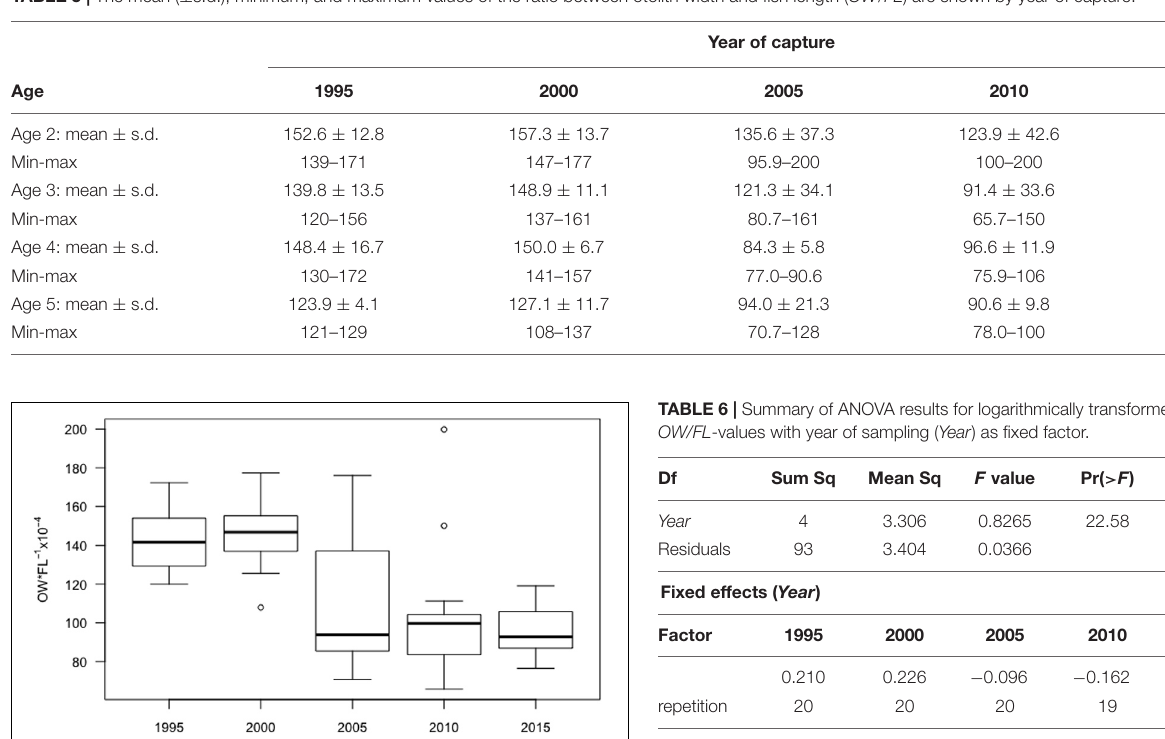
TABLE 5 | The mean ( ± s.d.), minimum, and maximum values of the ratio between otolith width and fish length ( OW / FL ) are shown by year of capture.